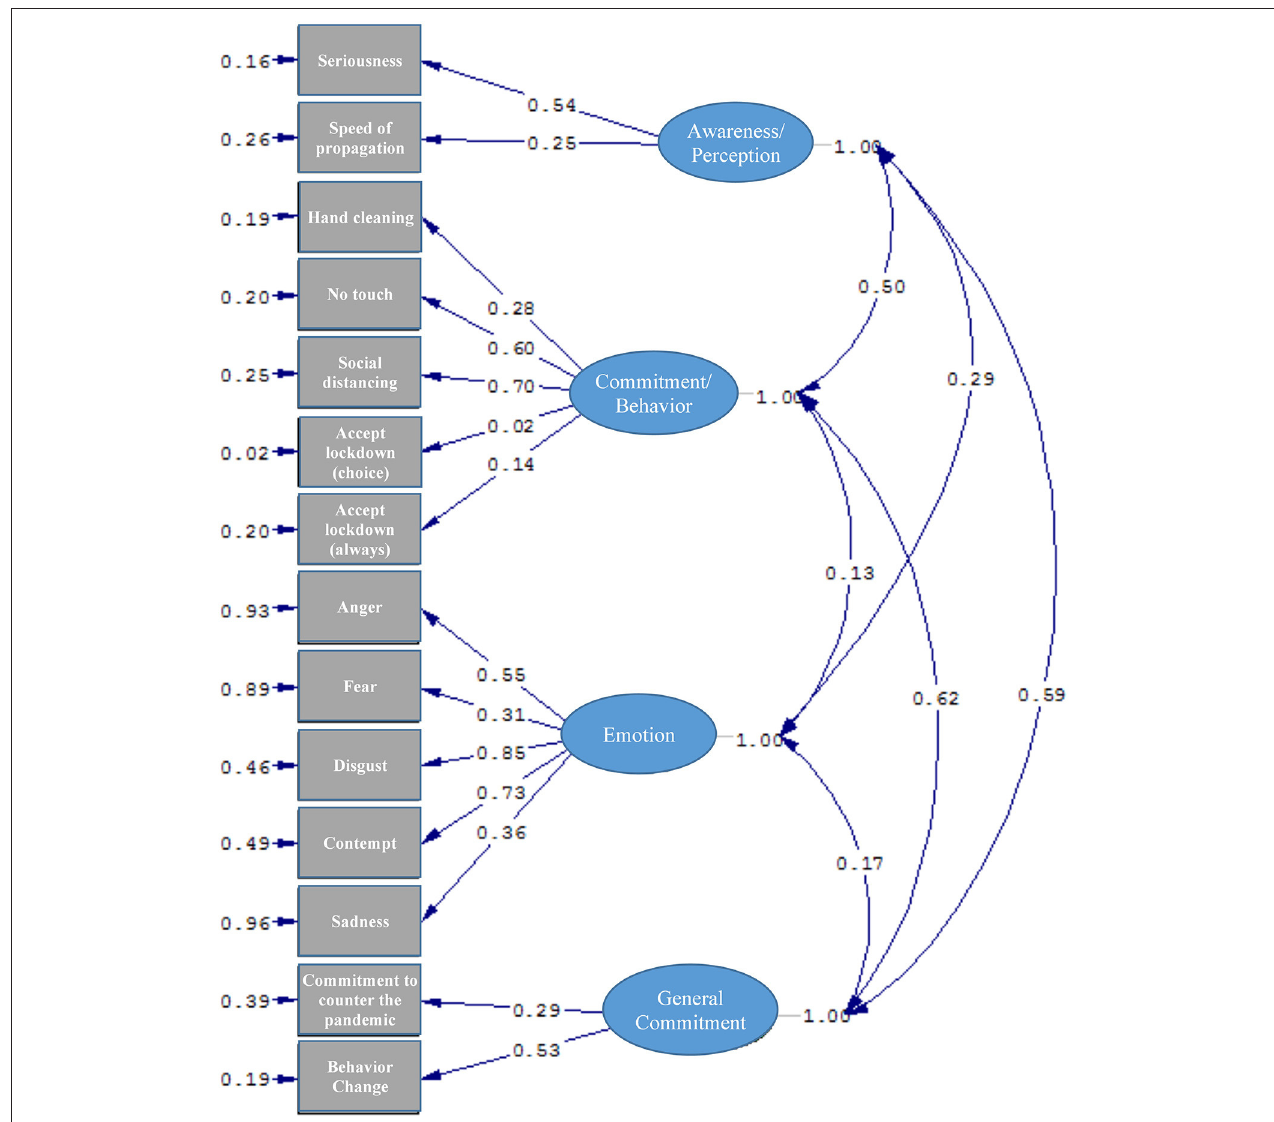
FIGURE 2 | The resulting model (Estimates) from the CFA analysis ( χ 2 = 968.69; df = 71; p < 0.001; RMSEA =